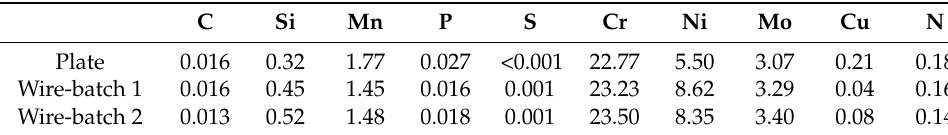
Table 2. Chemical compositions of the plate and wire (wt.%).